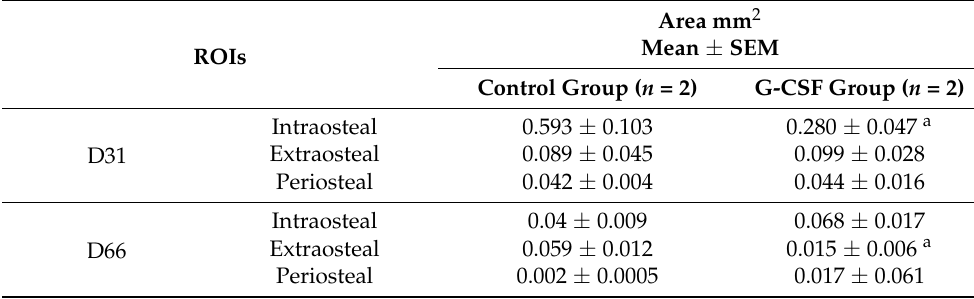
Table 2. Tartrate-resistant acid phosphatase (TRAP) analysis. Values are given as mean ± SEM. Compared to control group, a p <